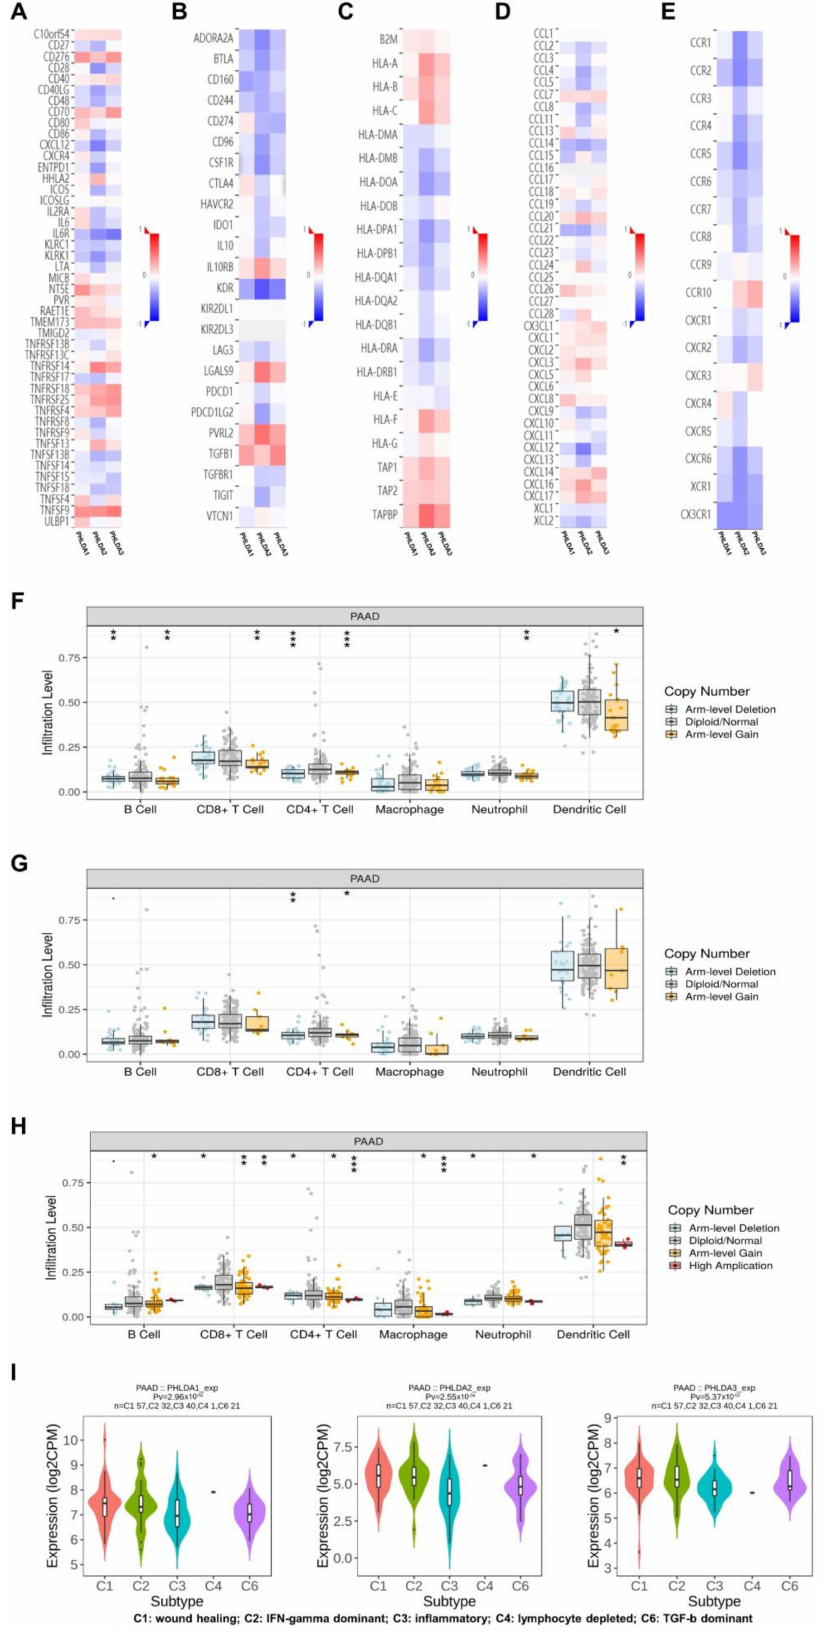
Figure 4. Analysis of the immune infiltration of the PHLDA family in PAAD. ( A – E ) PHLDA1 was positively correlated with 23 types of immune promoters, including IL6, NT5E, and TNFSF9,